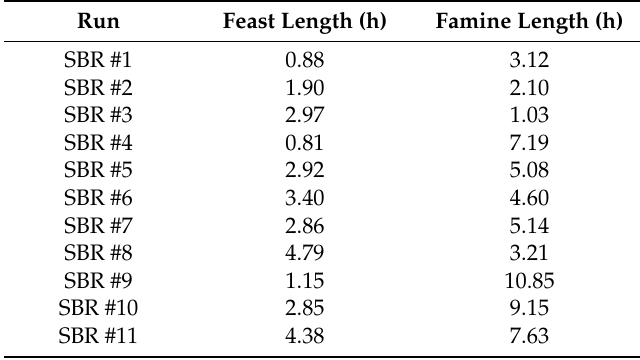
Table 2. Feast and famine phases length (by the end of operation) for the SBR runs described in Table 1. Run Feast Length (h) Famine Length (h) SBR #1